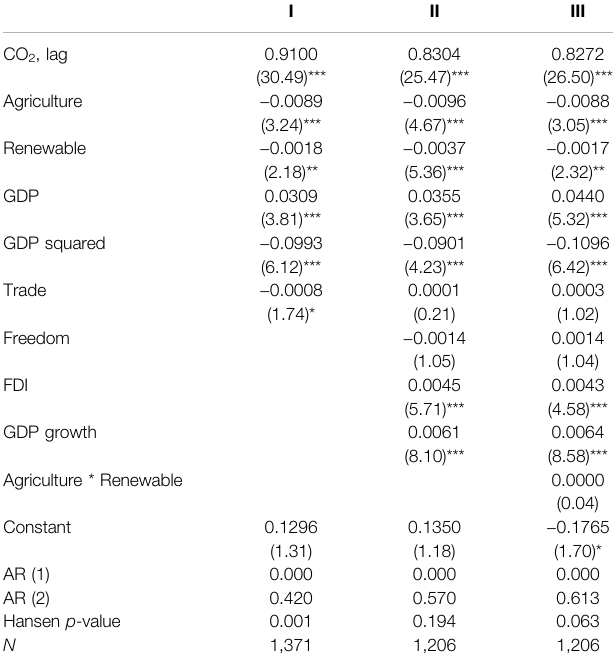
TABLE 3 | Baseline results.